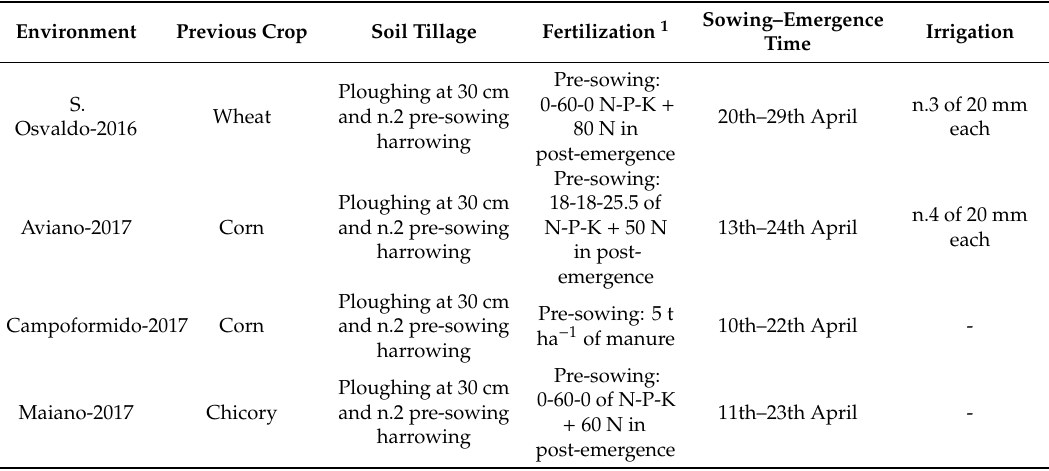
Table 2. Main cropping management techniques